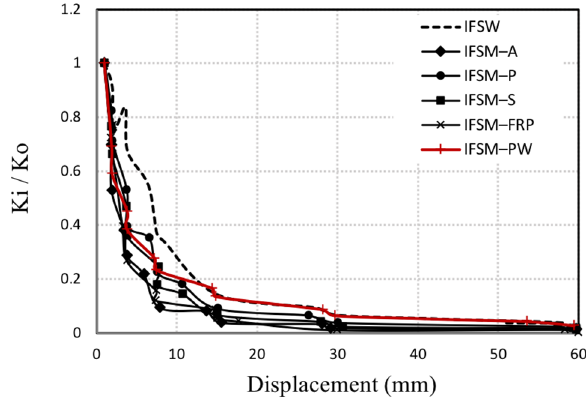
Figure 10. Stiffness degradation of specimens.